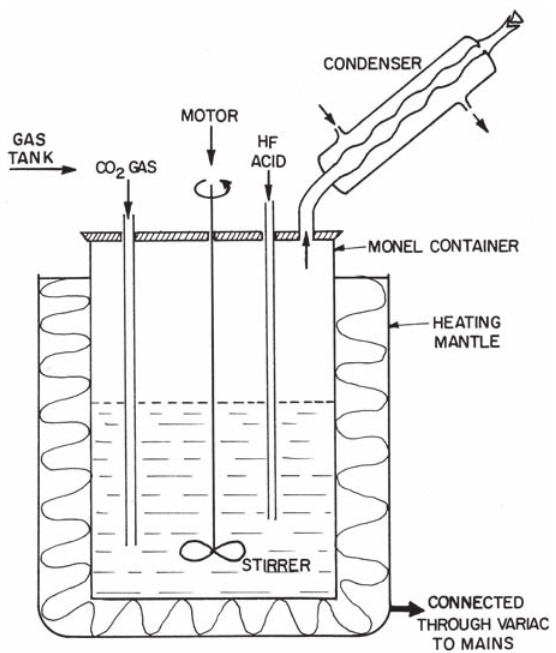
Fig. 1 Schematic drawing of the apparatus used for the laboratory synthesis of bastnaesite in the labo-